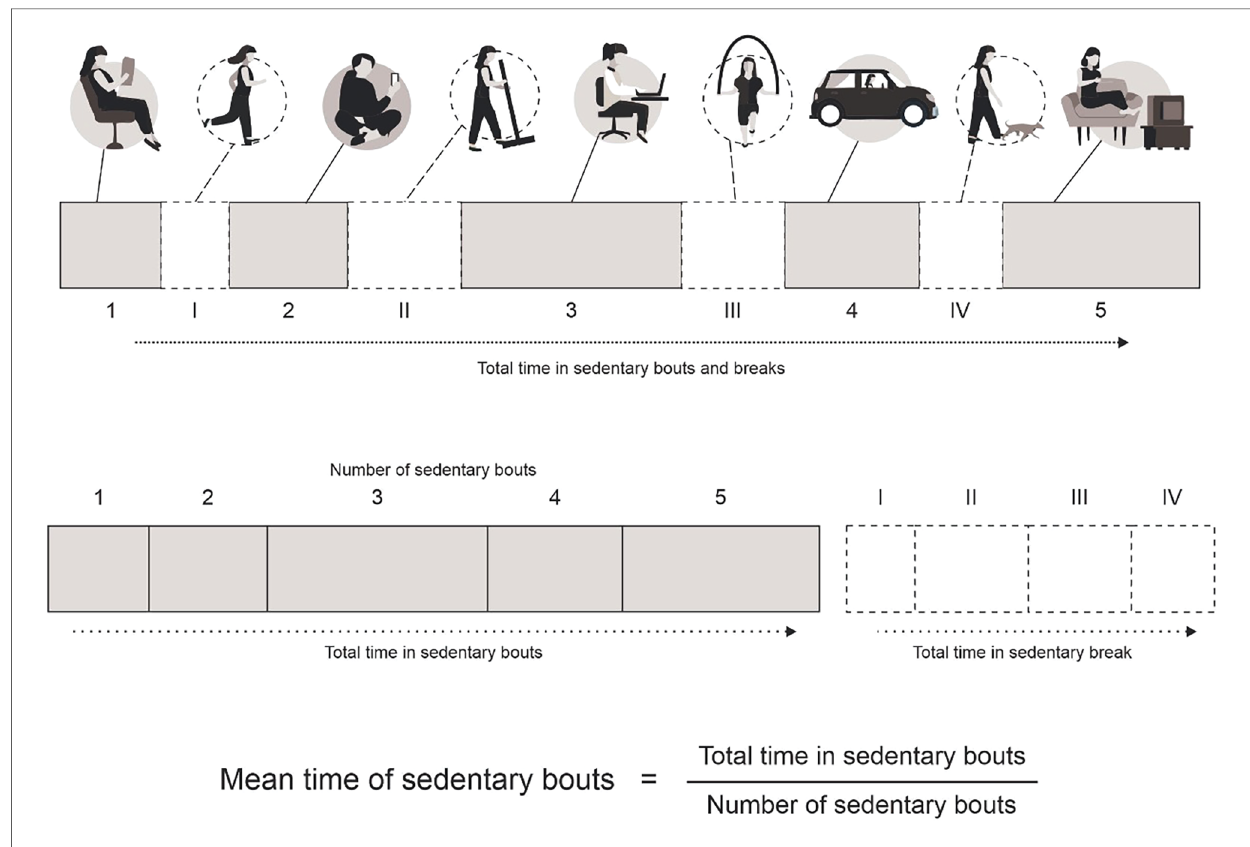
FIGURE 1 Schematic view of the sedentary behavior variables considered in the analyses.